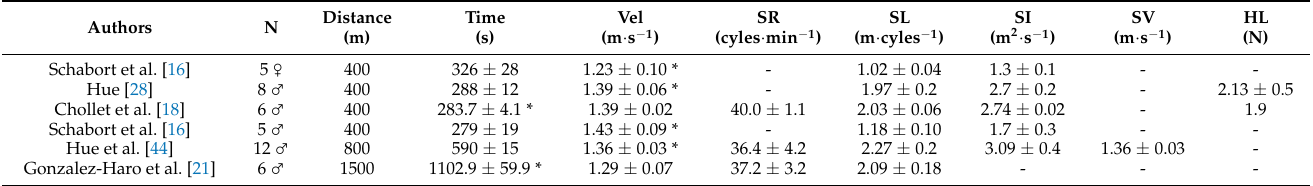
Table 6. Mean ± SD of swimming biomechanical parameters in elite